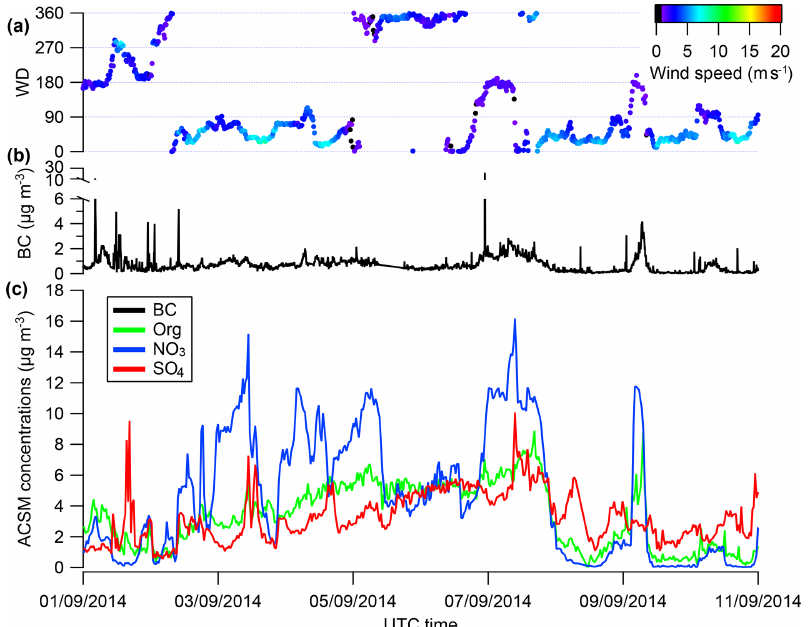
Figure A2. (a) Local wind speed and direction, mass concentrations of (b) black carbon and (c) ACSM sulfate, nitrate and organic aerosols in Dunkirk from 1 to 11 September